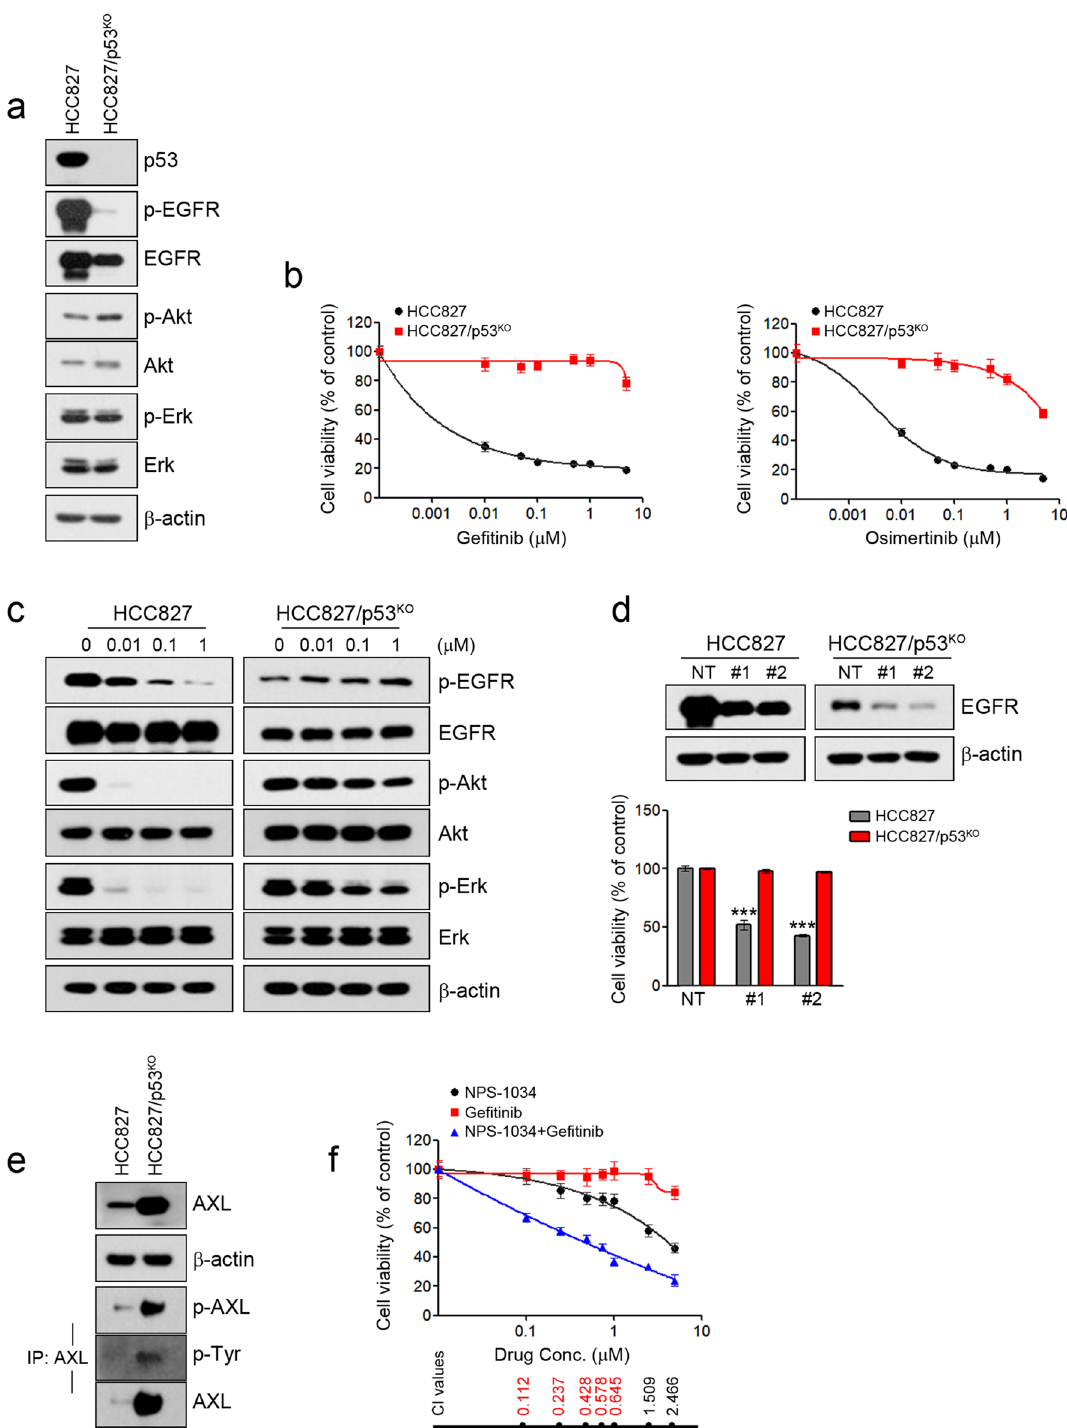
Figure 2. The effects of p53 on sensitivity to EGFR-TKIs in HCC827 cells. Endogenous p53 was silenced using a Crisper/Cas9 knockout system in HCC827 cells. ( a ) The indicated protein levels were analyzed by immunoblotting. ( b ) Cells were treated with the indicated doses of gefitinib or osimertinib for 72 h, and cell viability was determined using MTT assays. ( c ) Cells were treated with the indicated doses of gefitinib for 6 h, and EGFR-related signaling proteins were analyzed by immunoblotting. ( d ) Lentiviral constructs containing the negative control (NT) and EGFR shRNAs were introduced into the indicated cells, and EGFR suppression was confirmed by immunoblotting. Cell viability was measured by cell counting. ( e ) Lysates were immunoprecipitated with an anti-AXL antibody and immunoblotted with the indicated antibodies. ( f ) HCC827/p53KO cells were treated with gefitinib, NPS-1034 or a combination of the two drugs for 72 h. The combined effects were measured using the MTT assay. *** p < 0.0005 compared with negative control